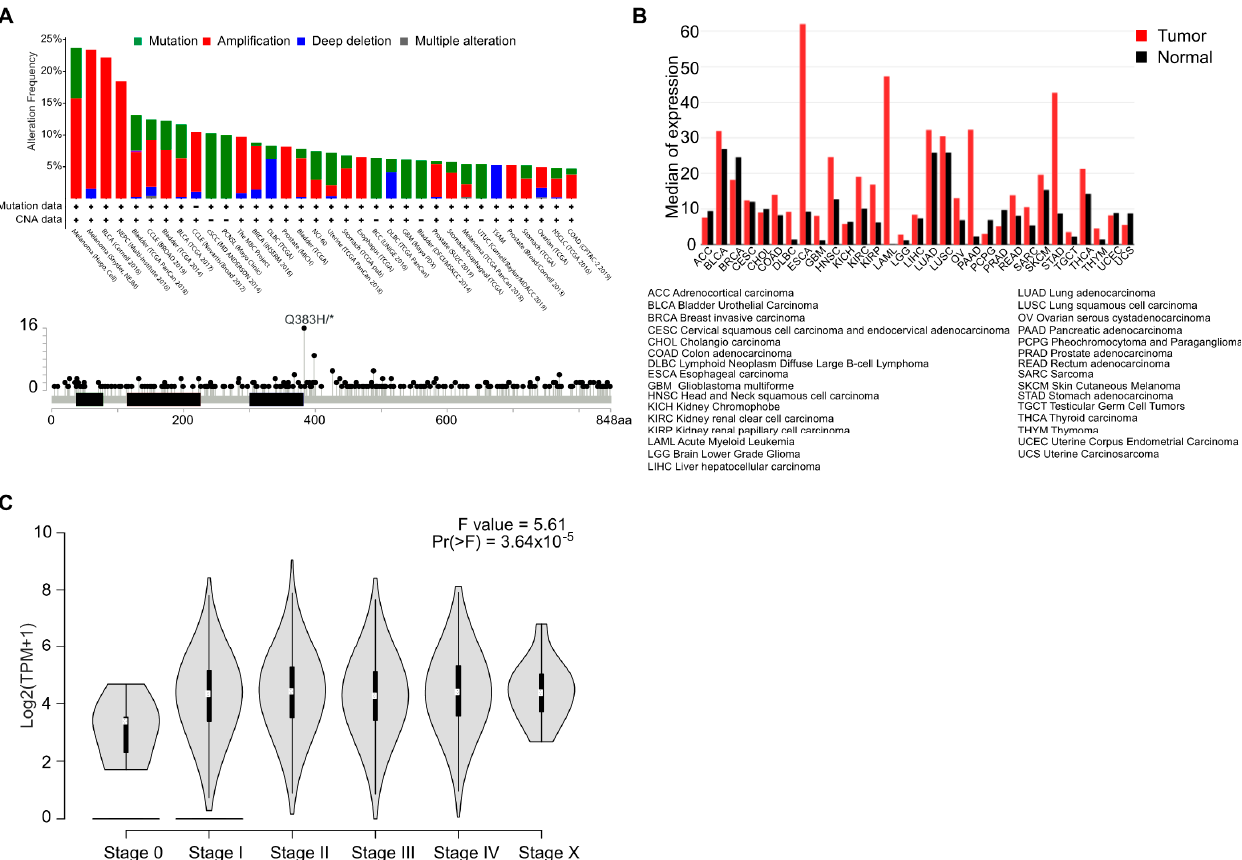
Figure 1. Status of the aryl hydrocarbon receptor (AhR) transcription factor status in cancer. ( A ) The frequency of alteration (top) and mutational status (bottom) of the AhR transcription factor was analyzed in all genetic and genomic data from patients or cancer cell lines from the cBioPortal for cancer genomics (http://www.cbioportal.org). AhR genetic alteration include mutation, amplification and deep deletion. ( B ) Analysis of AhR expression in all cancers from the TCGA compared to that in normal tissue using GEPIA 2 (Gene Expression Profiling Interactive Analysis, http://gepia2.cancer-pku.cn). ( C ) Analysis of AhR expression according to the staging of tumors described in